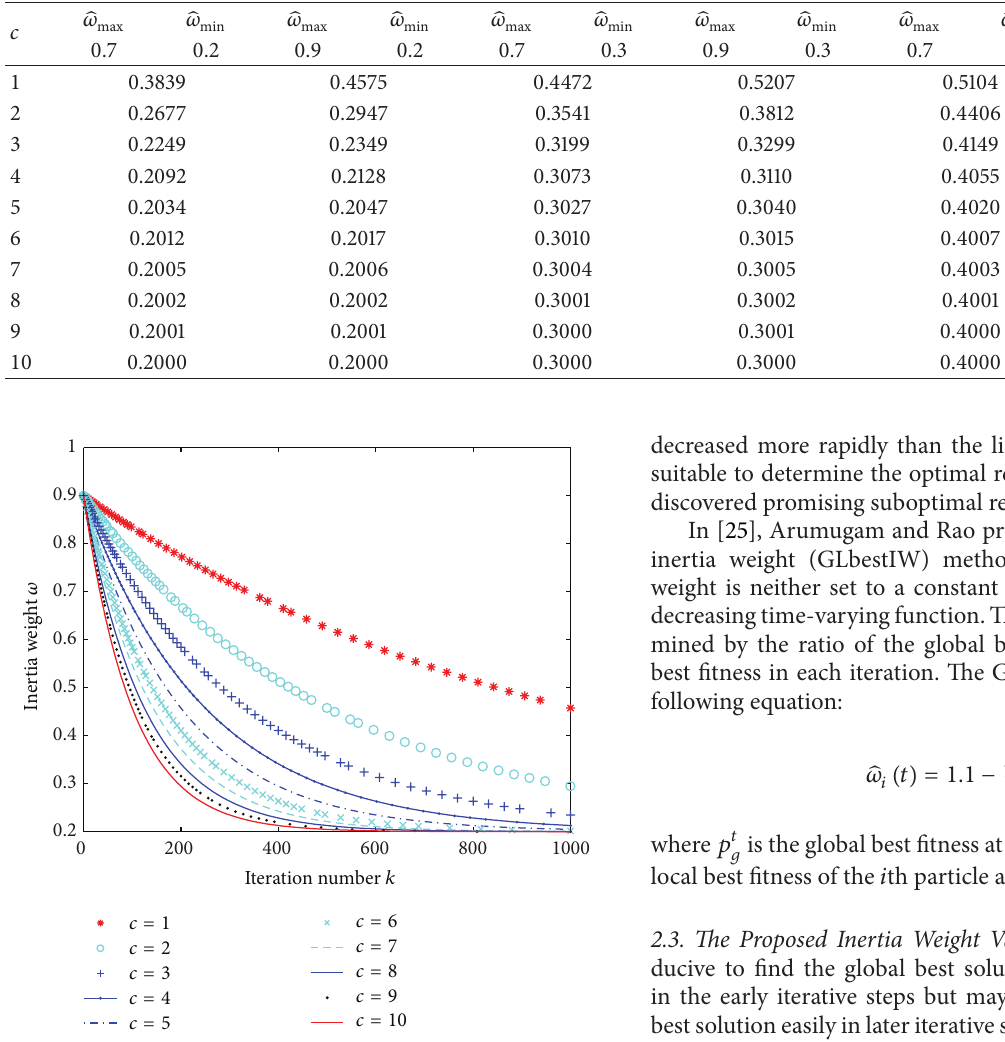
Figure 1: The decreasing curves of inertia weight ̂𝜔 attained by the proposed EDIW strategy for varying 𝑐